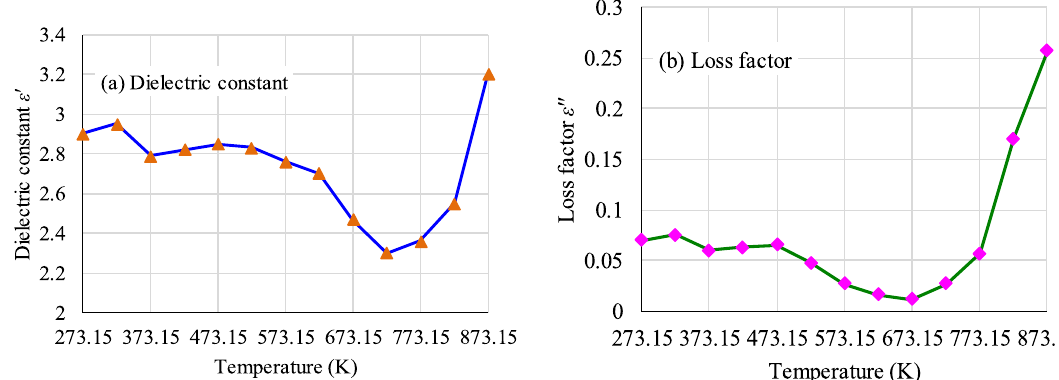
Figure 3. Variations of dielectric constant and loss factor of coal sample versus temperature at 2.45 GHz.